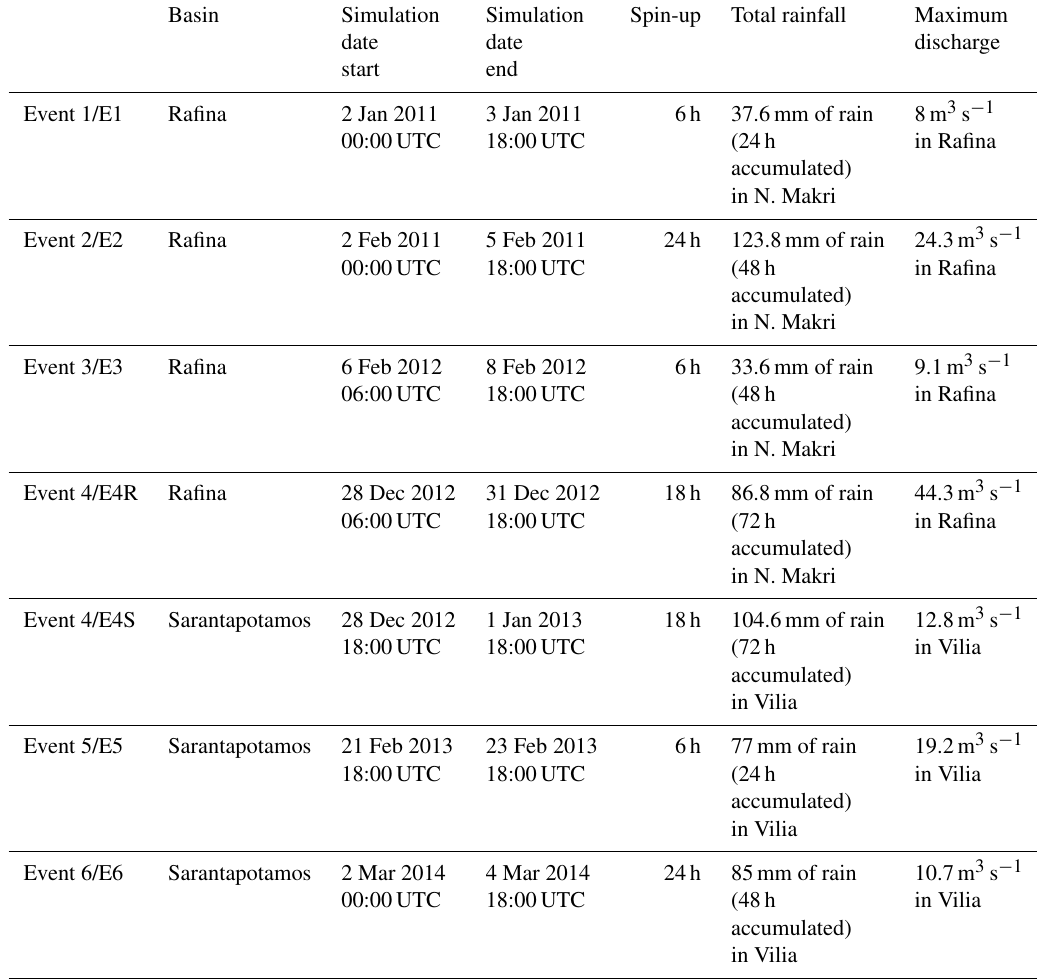
Table 1. Simulation periods of each event and hydrometeorological characteristics.